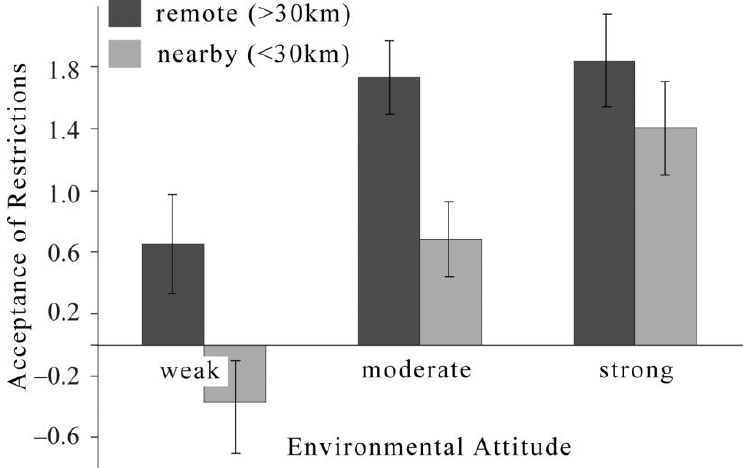
Figure 2. Remoteness-dependent acceptance of nature-preserve-related restrictions (NIMBY) moderated by people’s attitudes toward environmental protection ( i.e ., environmental attitude). Vertical bars indicate 95% confidence